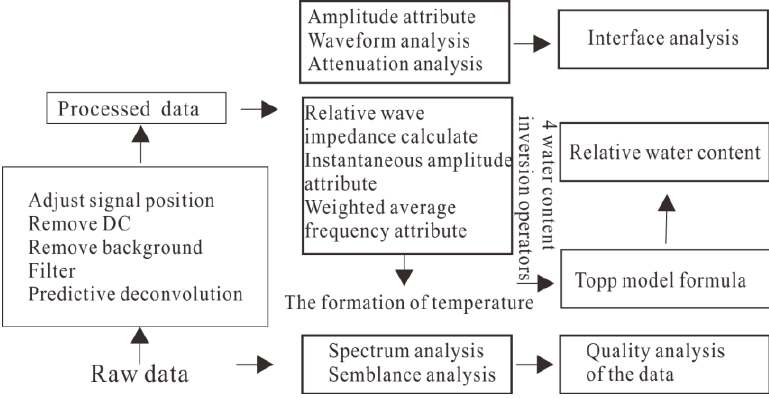
Figure 11. Method flow diagram.